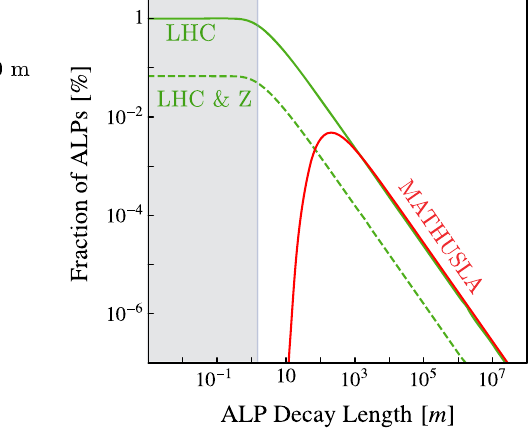
h → aZ (green), fraction of ALPs produced decaying in ATLAS/CMS togetherwithaleptonicallydecaying Z (dashedgreen),andthepercent- age of ALPs decaying within the MATHUSLA detector volume (red). The gray area shows the distance between the interaction point and the electromagnetic